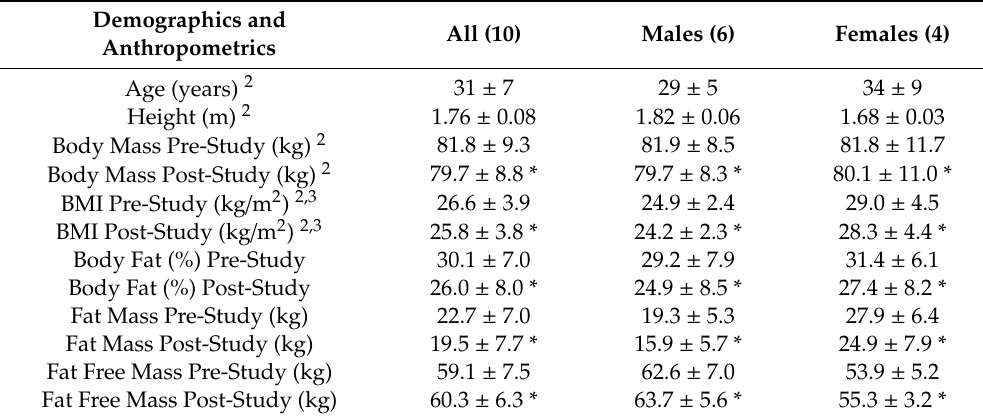
Table 1. Demographic and anthropometric characteristics of winter weather (arctic-like) field training exercise study participants (n = 10) 1